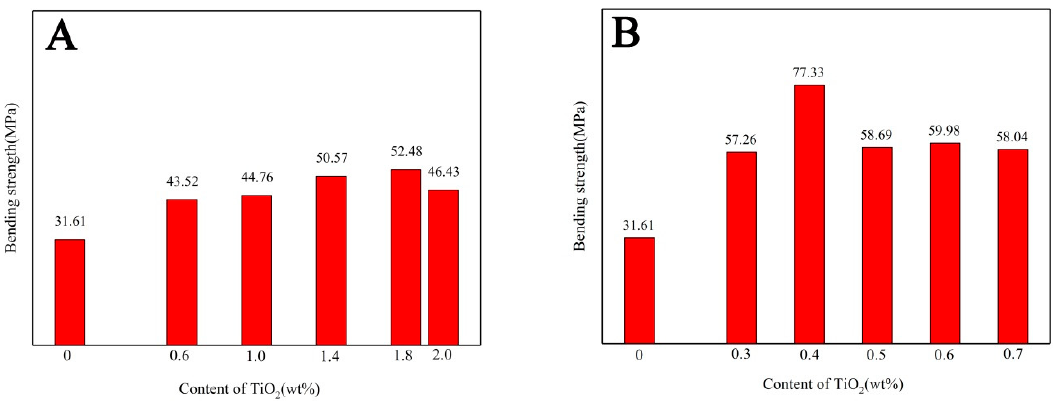
Figure 2. Bending strength of ceramic membrane supports with different contents of TiO 2 by ( A ) in-situ precipitation and ( B ) in-situ hydrolysis.